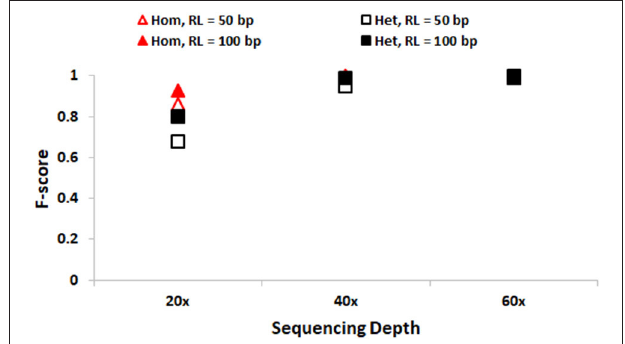
FIGURE 2 | Performance of SeqVItA in detecting SNVs in simulated data shown. F-score values for detecting homozygous “triangle” and heterozygous “square” SNVs with read length 50 bp (empty symbols) and 100 bp (filled symbols). Minimum coverage threshold = 10 and Base quality ≥